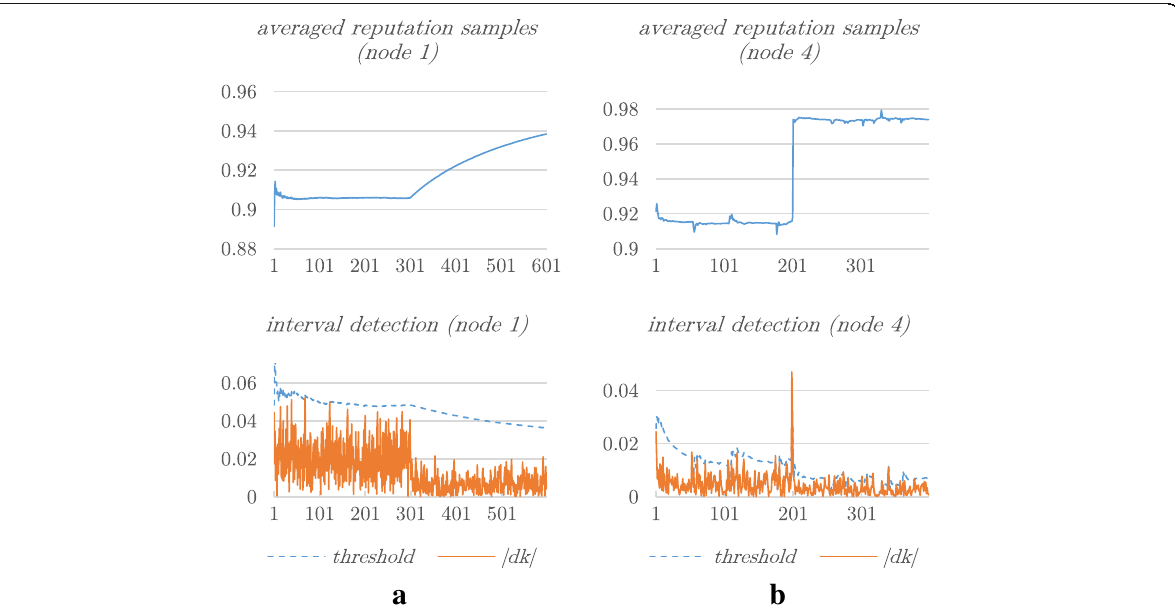
Fig. 7 Average value of the samples (figures at the top) and interval detection (figures below) when β =0.7 and F =2: a for node 1 and b for node